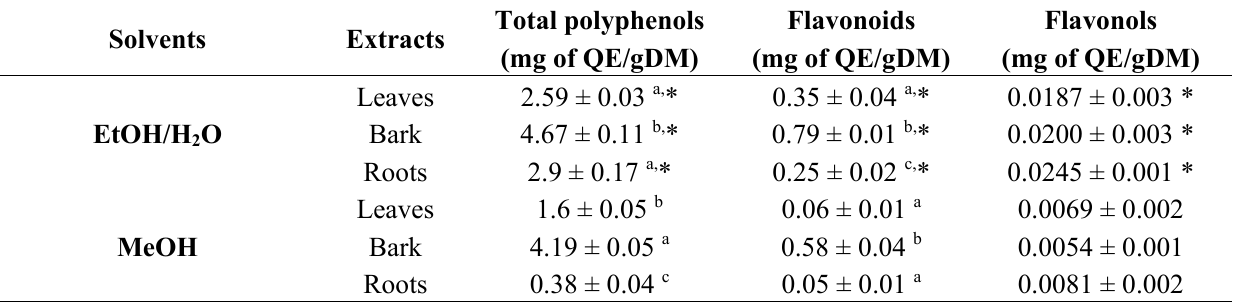
Table 3. Phenolic content of S. guineensis.